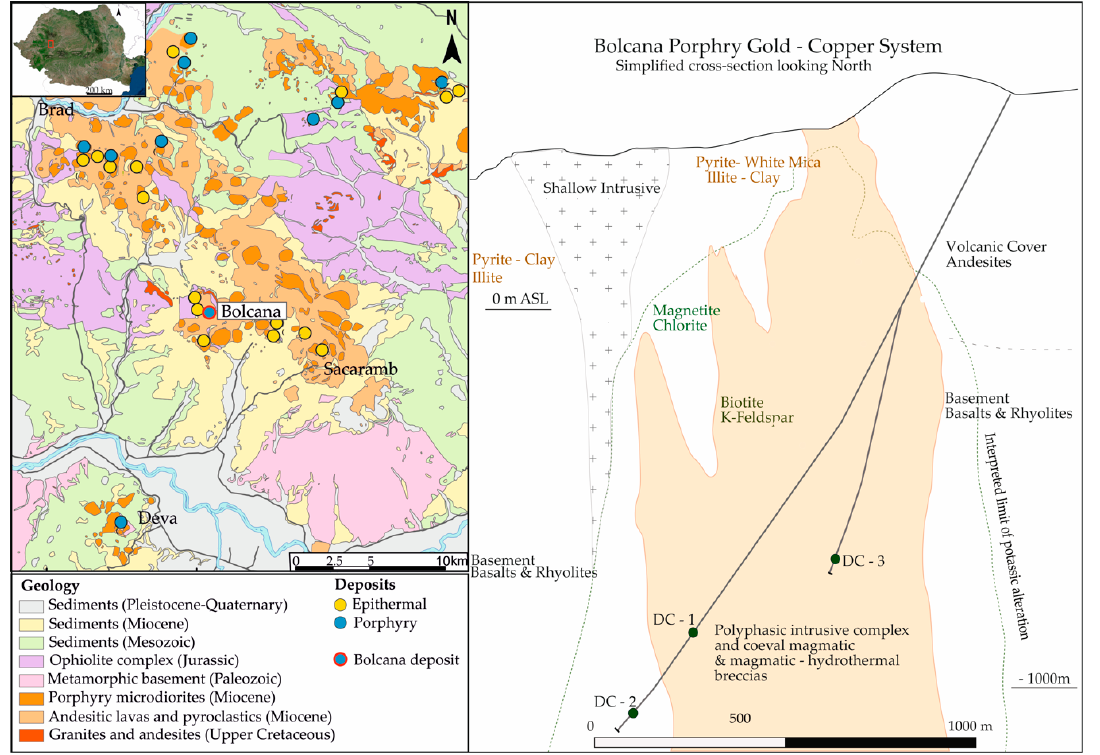
Figure 1. Geological map of the Brad-Sacaramb metallogenic district ( left ) and E–W cross section through the Bolcana porphyry system with shown location of the sampled drill-holes ( right ).